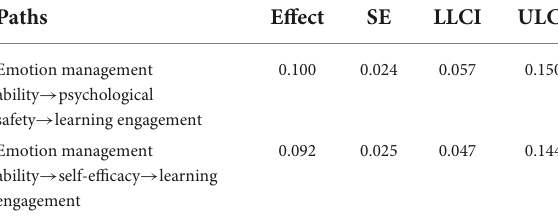
TABLE 4 Results of bootstrapping mediation effect